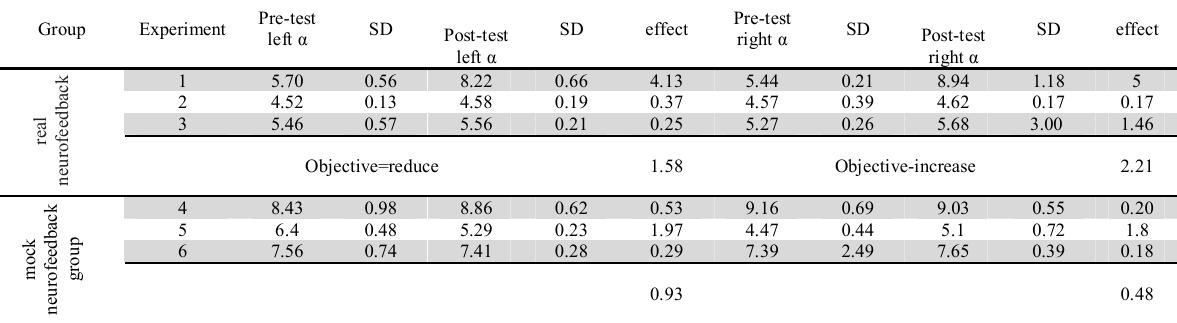
The results of Kuhn d on left and right of pre-test left α, post-test α